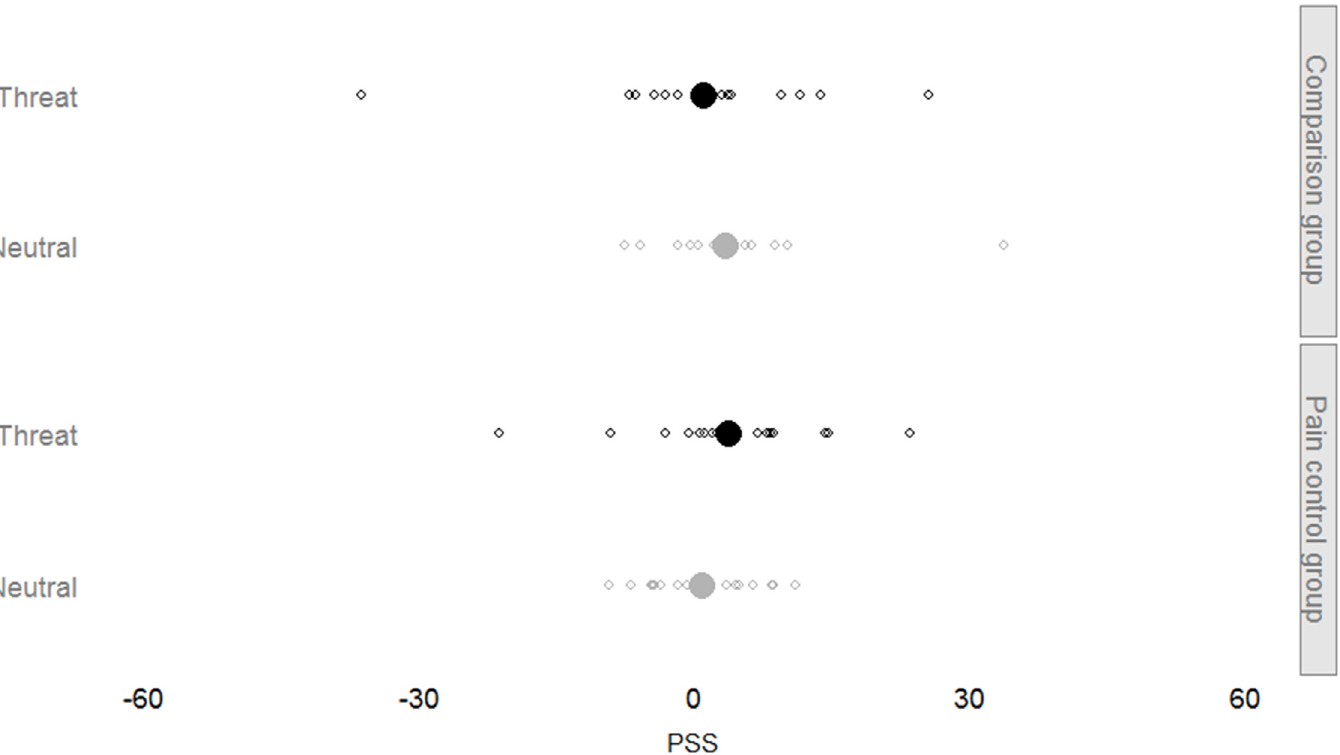
Fig 3. Midpoint PSS overview. Similar to the procedure for peak PSS values, we also compared PSS values using midpoint measurements. Again, no distinctive biases can be demonstrated using these